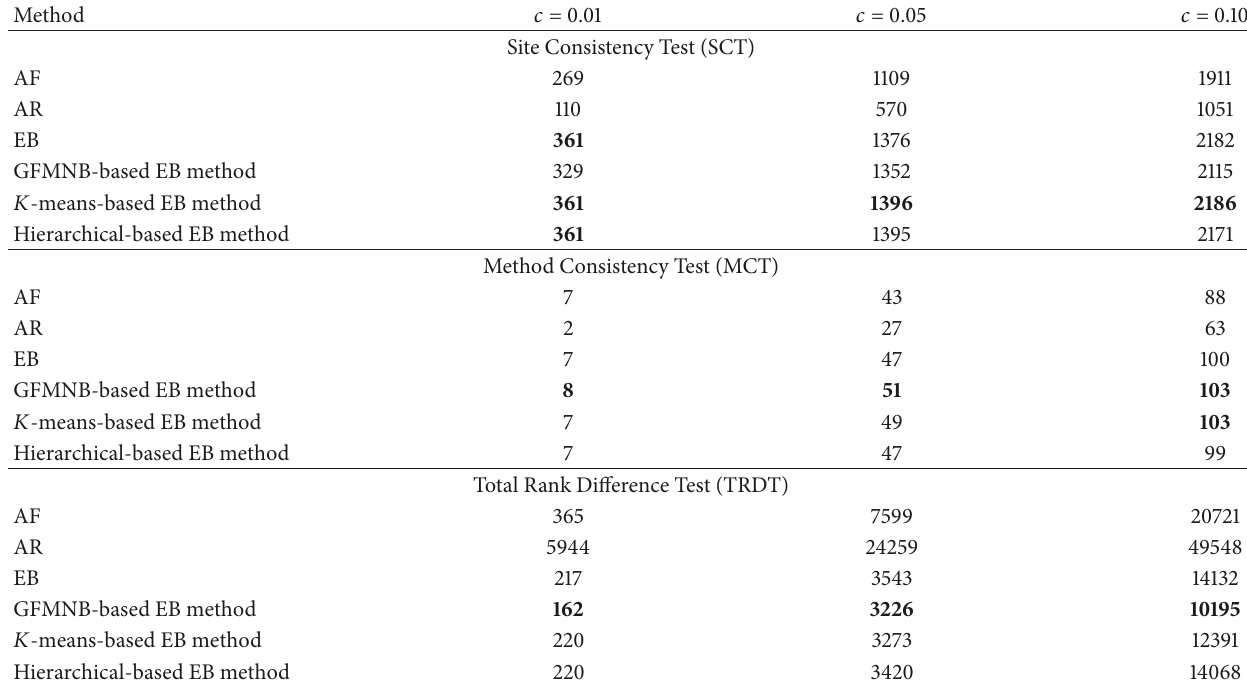
Table 4: Results for various methods using three different